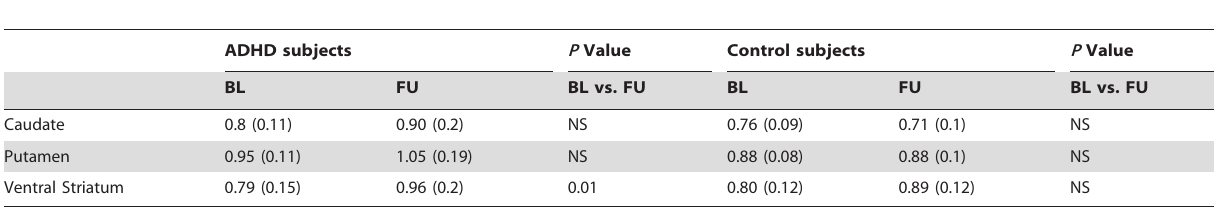
Table 3. Measures [mean (SD)] of dopamine transporter availability (BP ND ) of control subjects at baseline (BL) and 12 months follow-up (FU) and ADHD subjects prior to (BL) and after 12 months oral methylphenidate treatment